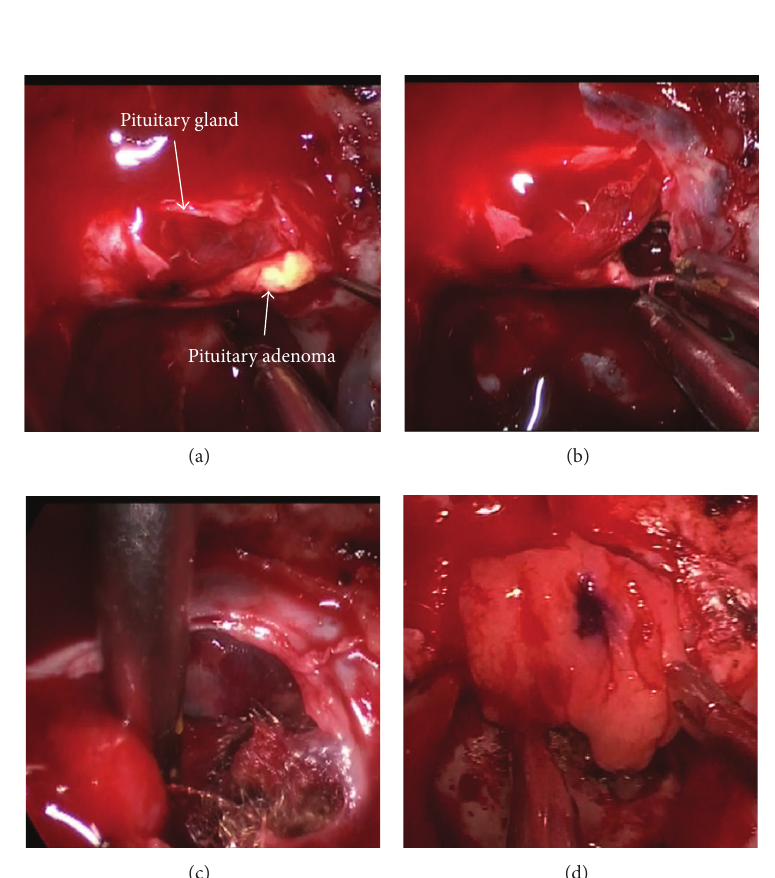
Figure 3: (a) Neuroendoscope shows the clear margin between normal gland and PA. PA looks soft and yellowish. (b) Neuroendoscopic view after removal of the PA, which was easy to remove. (c) Neuroendoscope shows the wall of the RCC. Resecting the suprasellar RCC while retracting normal gland was difficult. (d) The floor of the sella turcica was reconstructed using fat tissue. We did not aspirate or resect the cyst